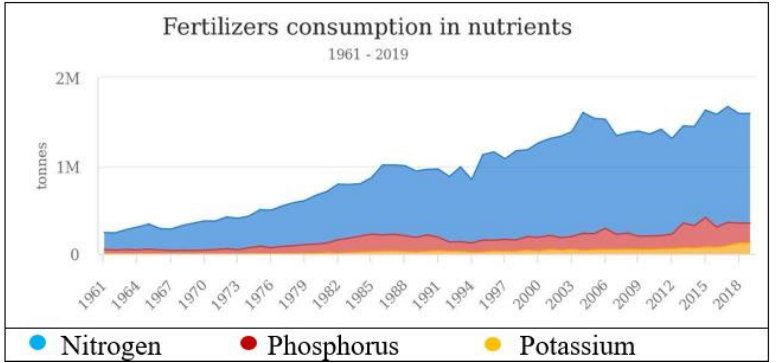
Figure 2. The total consumed fertilizers for the main three nutrients in Egypt from 1961 to 2019 according to FAO data [54].